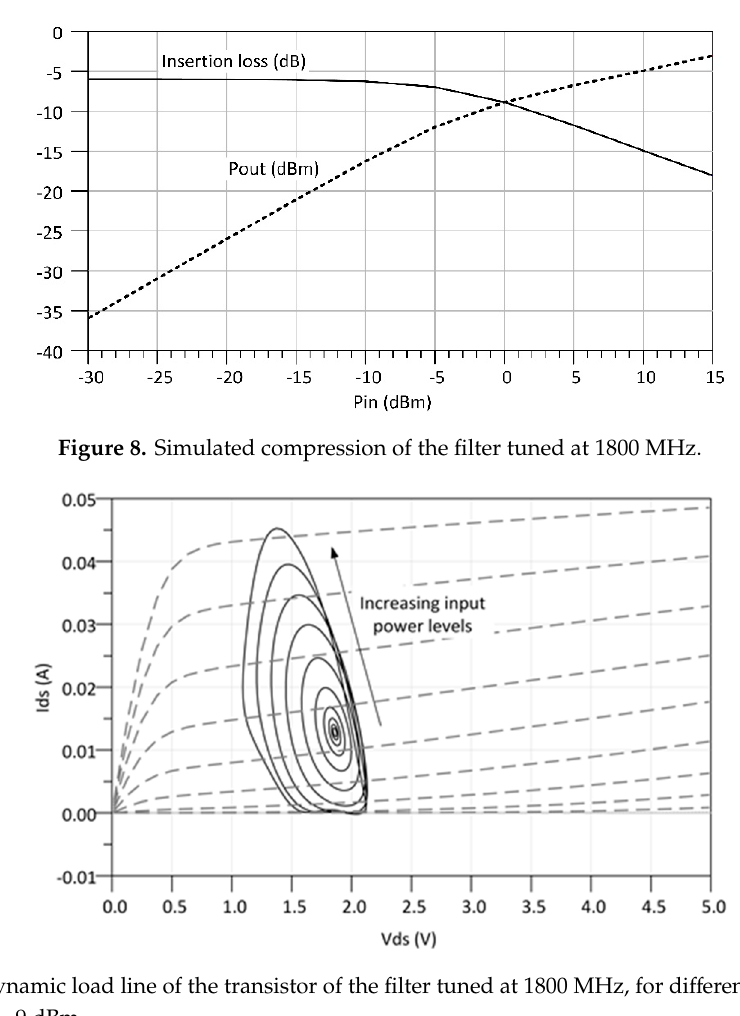
Figure 9. Dynamic load line of the transistor of the filter tuned at 1800 MHz, for different input power levels up to − 9 dBm.